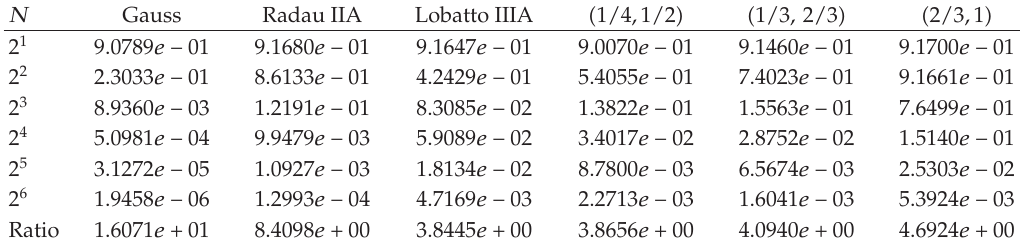
Table 3: The absolute values of absolute errors of u h for example (cid:2) 7.2 (cid:3) with m (cid:4) 2.